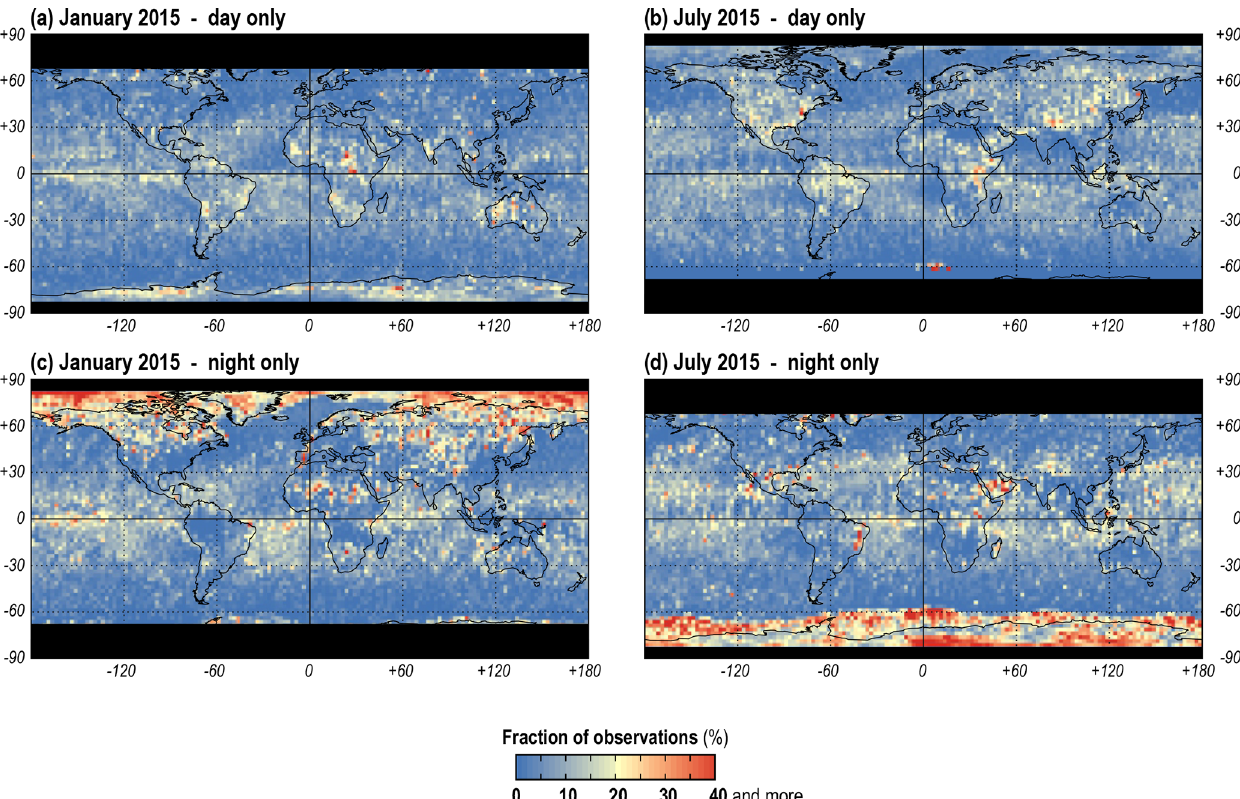
Figure 1. Observations declared confident clear or probably clear by the MODIS cloud masking algorithm but identified as cloudy by